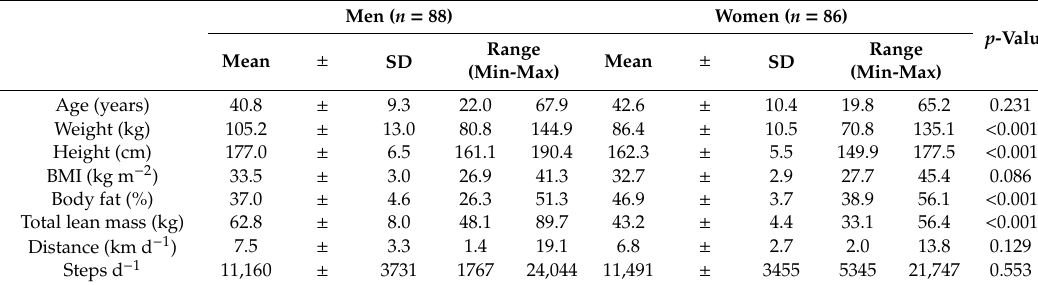
Table 1. Characteristics of the study